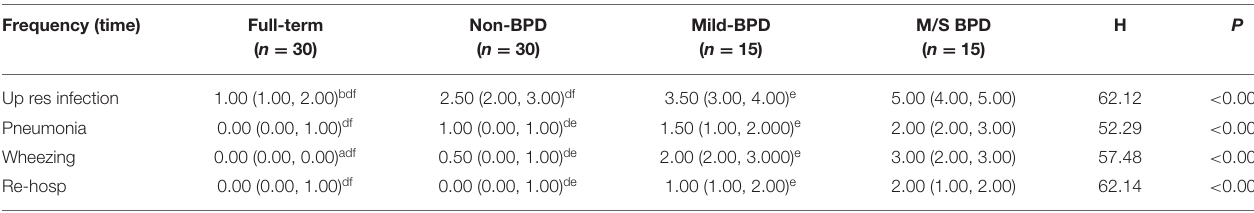
TABLE 3 | Respiratory infections and re-hospitalization in the four groups.